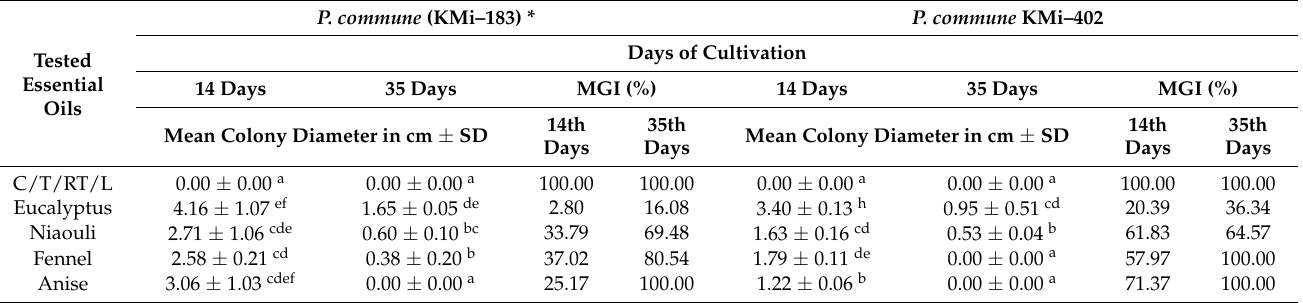
Table 1. In vitro inhibitory effects of essential oils at 25 ± 1 and 5 ± 1 ◦ C after 14 days of cultivation and 35 days of cultivation on growth of Penicillium commune strains (KMi–183 and KMi–402) (PDs divided into three sectors in independent repetition were used ( n =